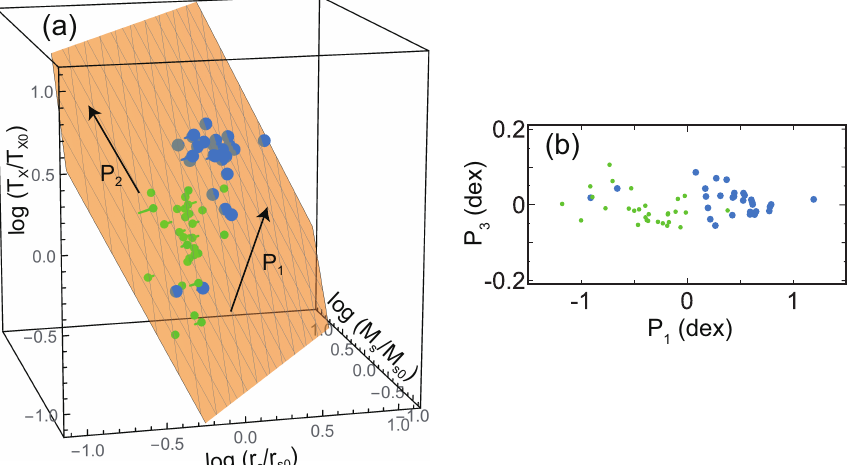
Figure 4. ( a ) The results of simulations including radiative cooling and feedback. The blue (FB0) and the green dots (FB1) are the results for z = 0 and 1, respectively. The axes are normalized by the average parameters of the combined sample ( r s 0 = 388 kpc, M s 0 = 1.4 × 10 14 M (cid:12) , and T X 0 = 4.8 keV). The orange plane is the best fit of the data. The arrow P 1 shows the direction to which the data distribution is most extended, and the arrow P 2 is perpendicular to P 1 on the plane. ( b ) The cross-section of the plane in ( a ). The direction P 3 is the plane normal (Figure is reconstructed from Figure 4 of